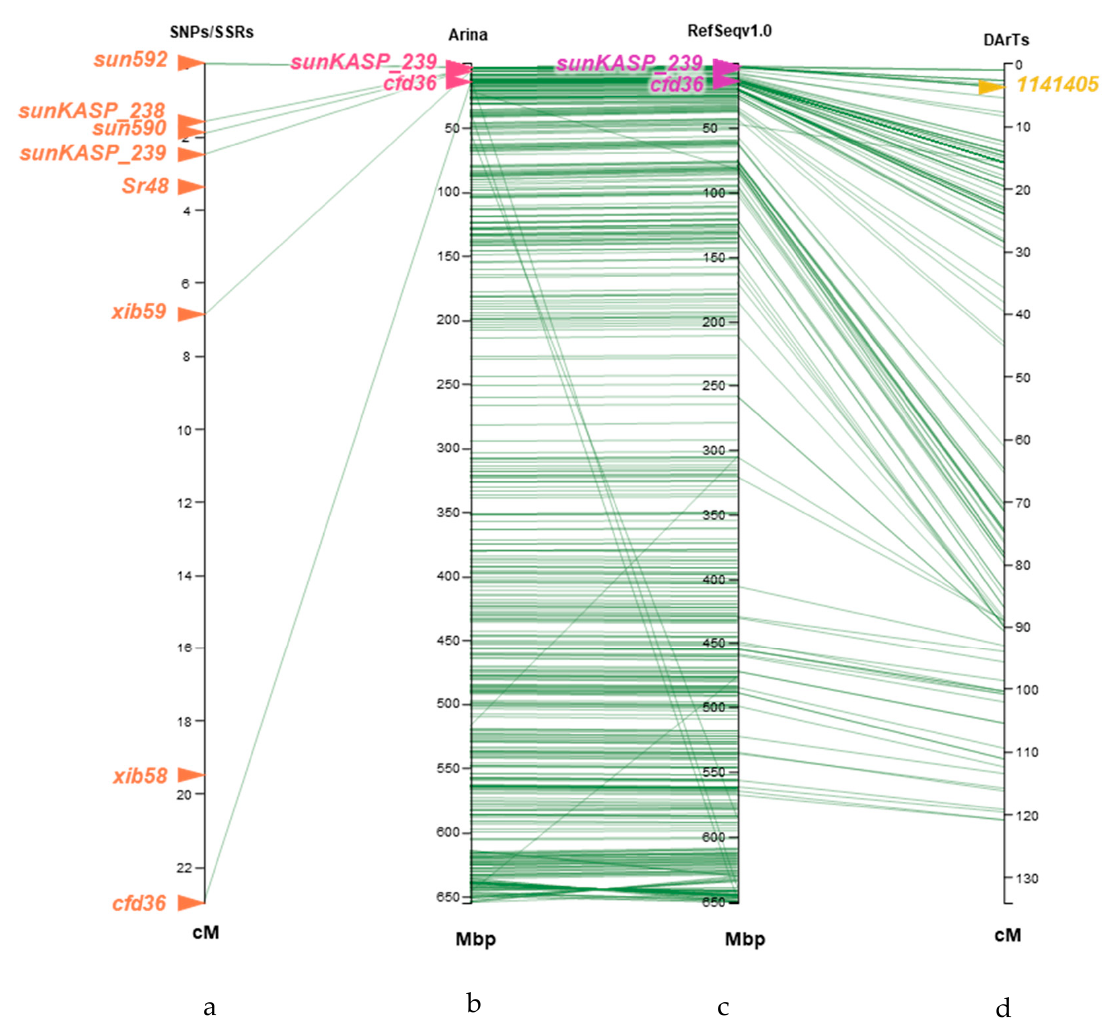
Figure 3. Comparison of location of Sr48 -linked markers on chromosome 2DS ( a ) Arina 2D pseudo- molecule ( b ) IWGSC RefSeqv 1.0-based 2DS ( c ) and DArT markers ( d ) of Arina/Cezanne RIL popu-